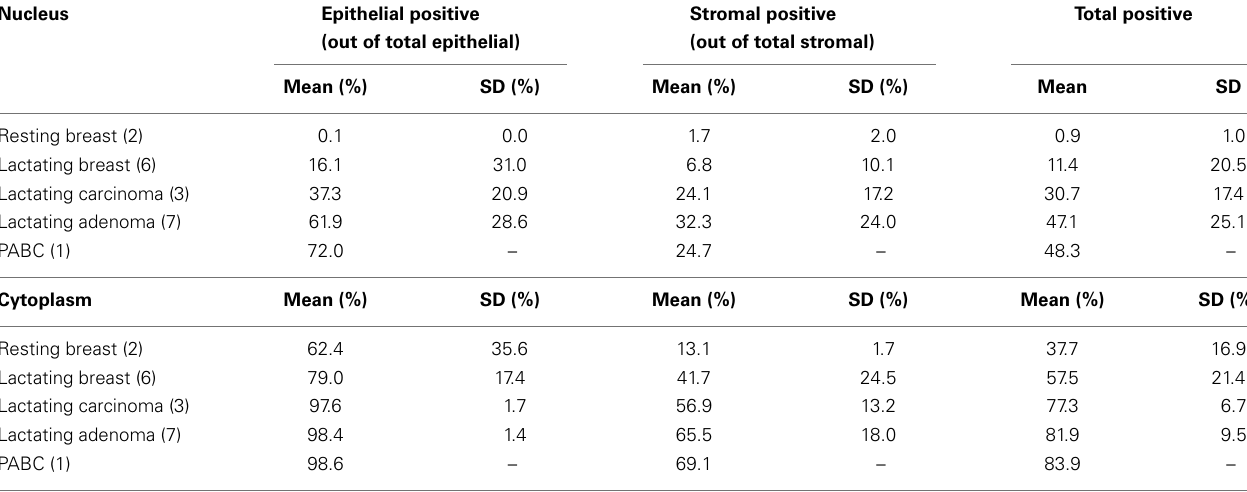
Table 3 | Mean levels and standard deviations (SD) of OCT4 expression in the tissues